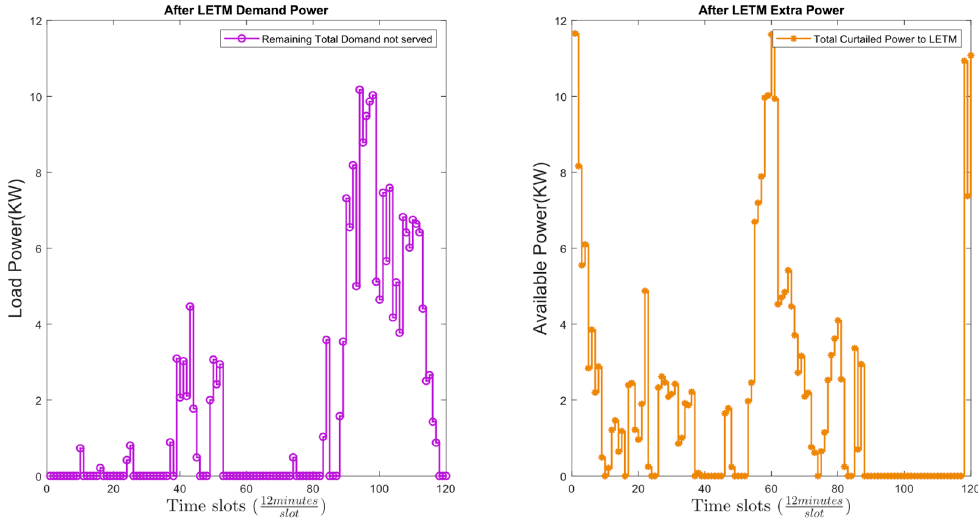
Figure 20. Power demand and surplus after LETM for scheduled load.